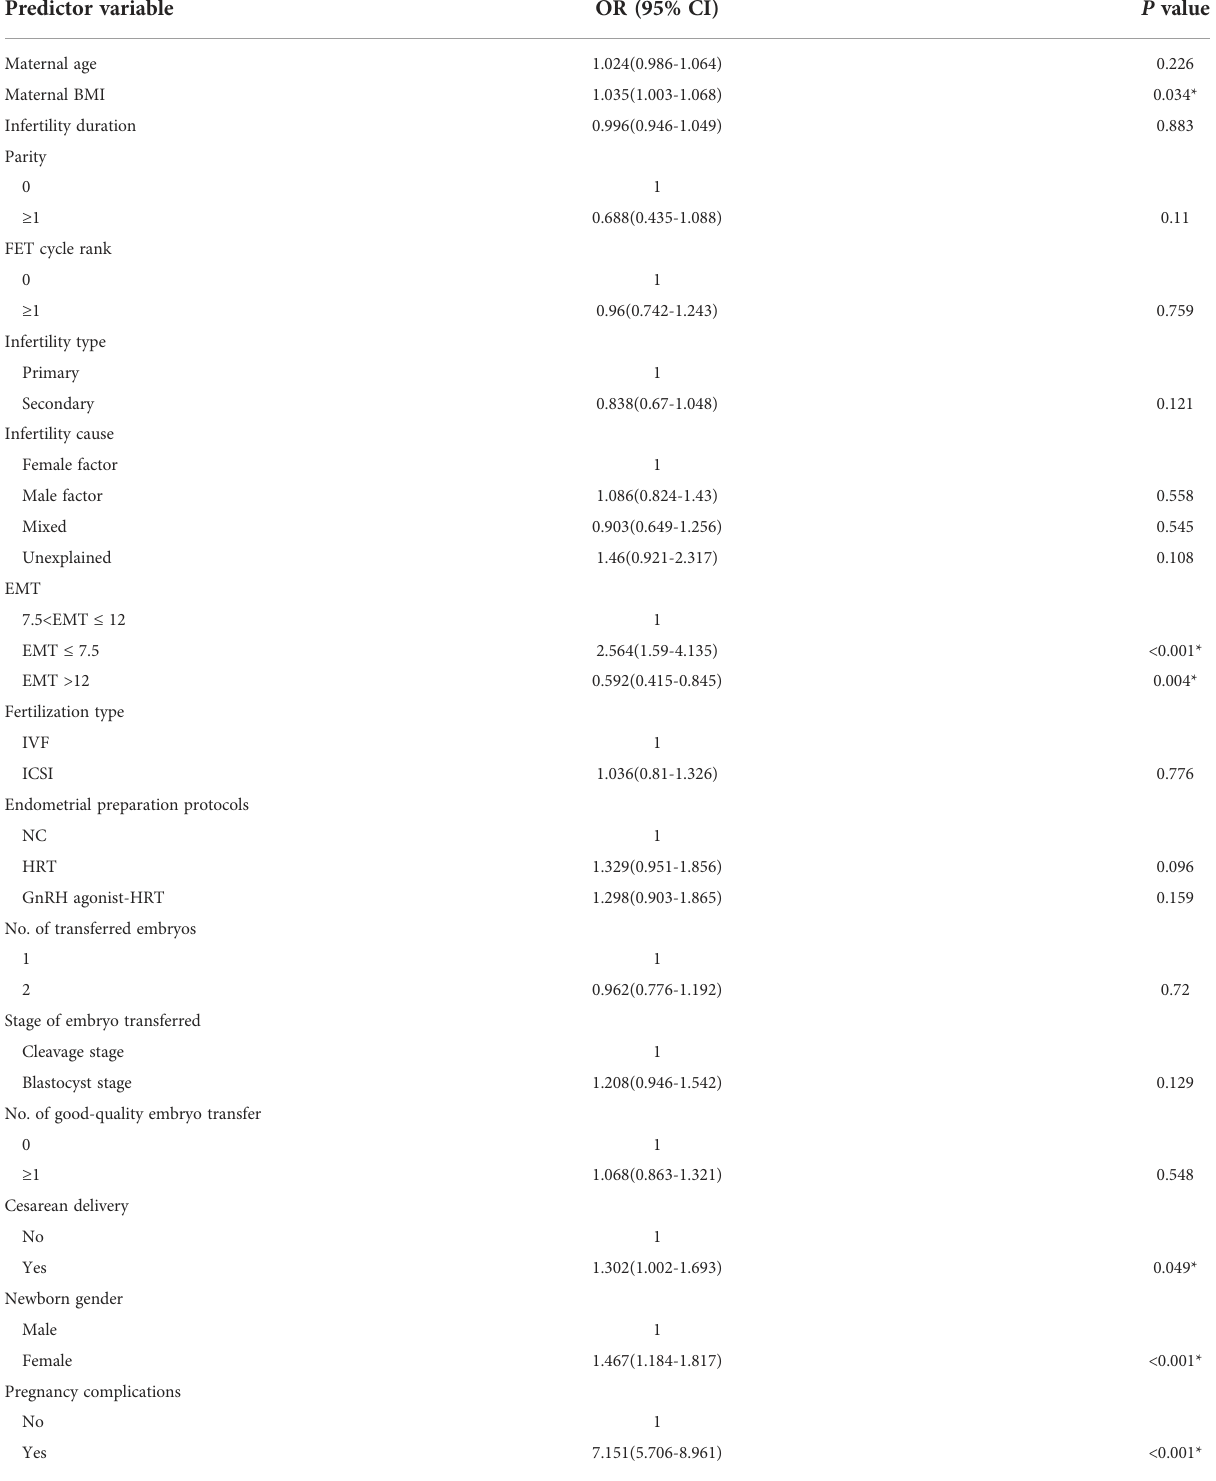
TABLE 3 Odds ratios of LBW by univariate analysis of predictor